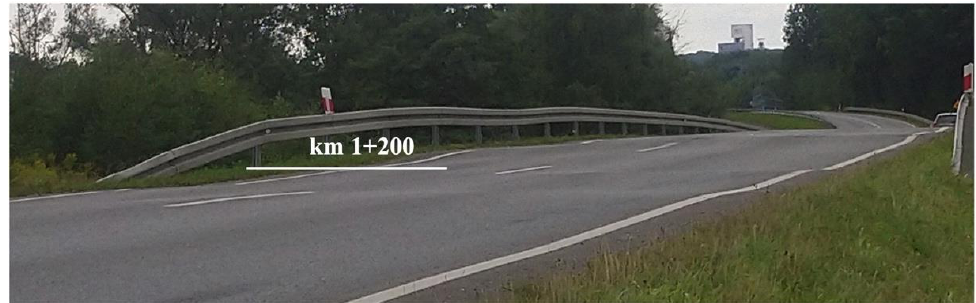
Figure 6. Example of a continuous deformation of the road surface on the section of about km 1 + 200.